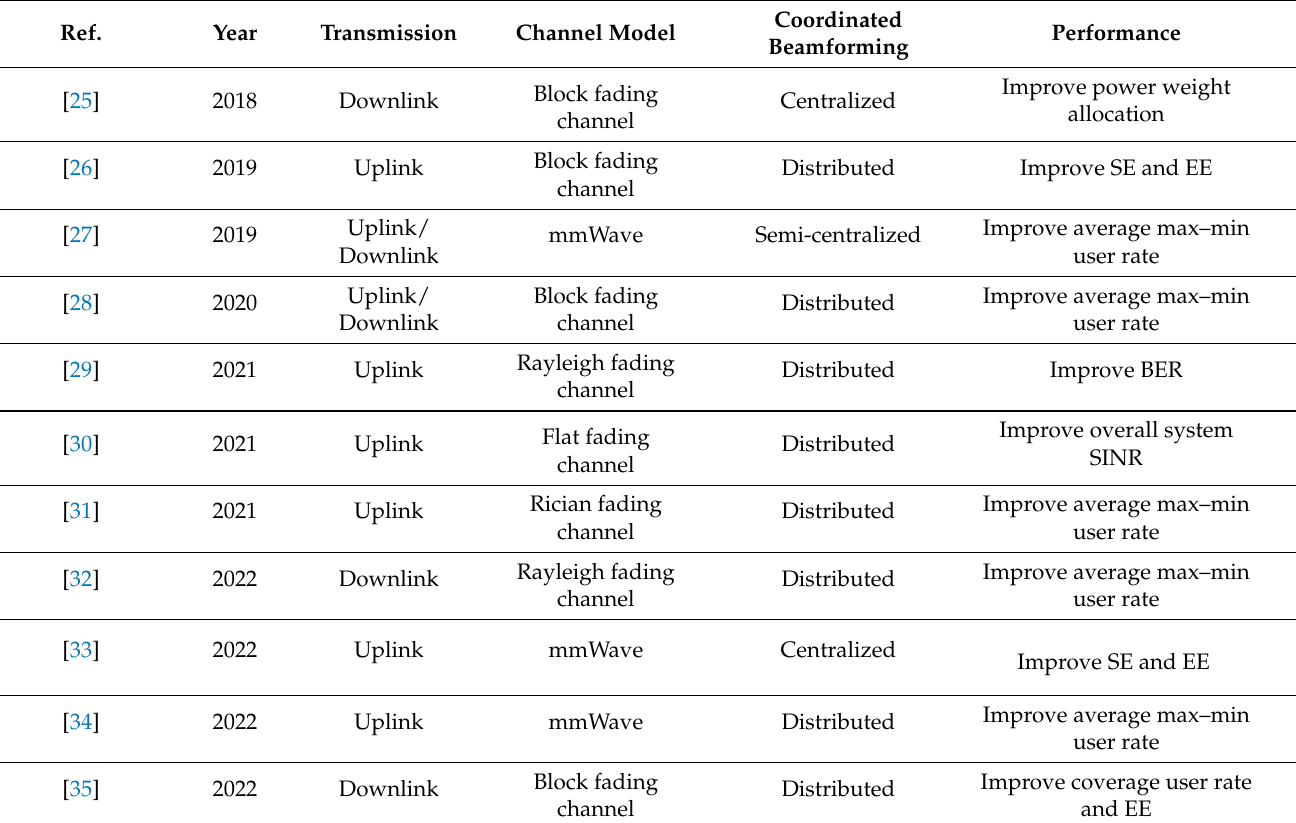
Table 1. A literature comparison for CF mMIMO systems with limited fronthaul capacity.